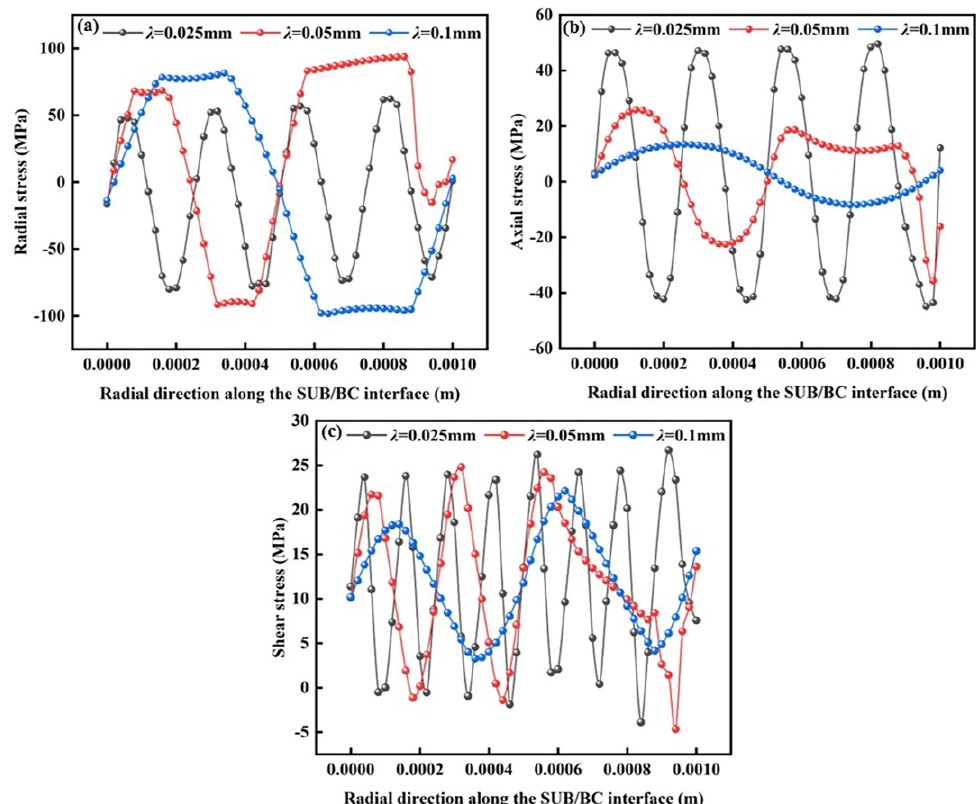
Figure 12. Stress distributions of SUB/BC interface at different wavelengths: ( a ) radial stress; ( b ) axial stress and ( c ) shear stress.